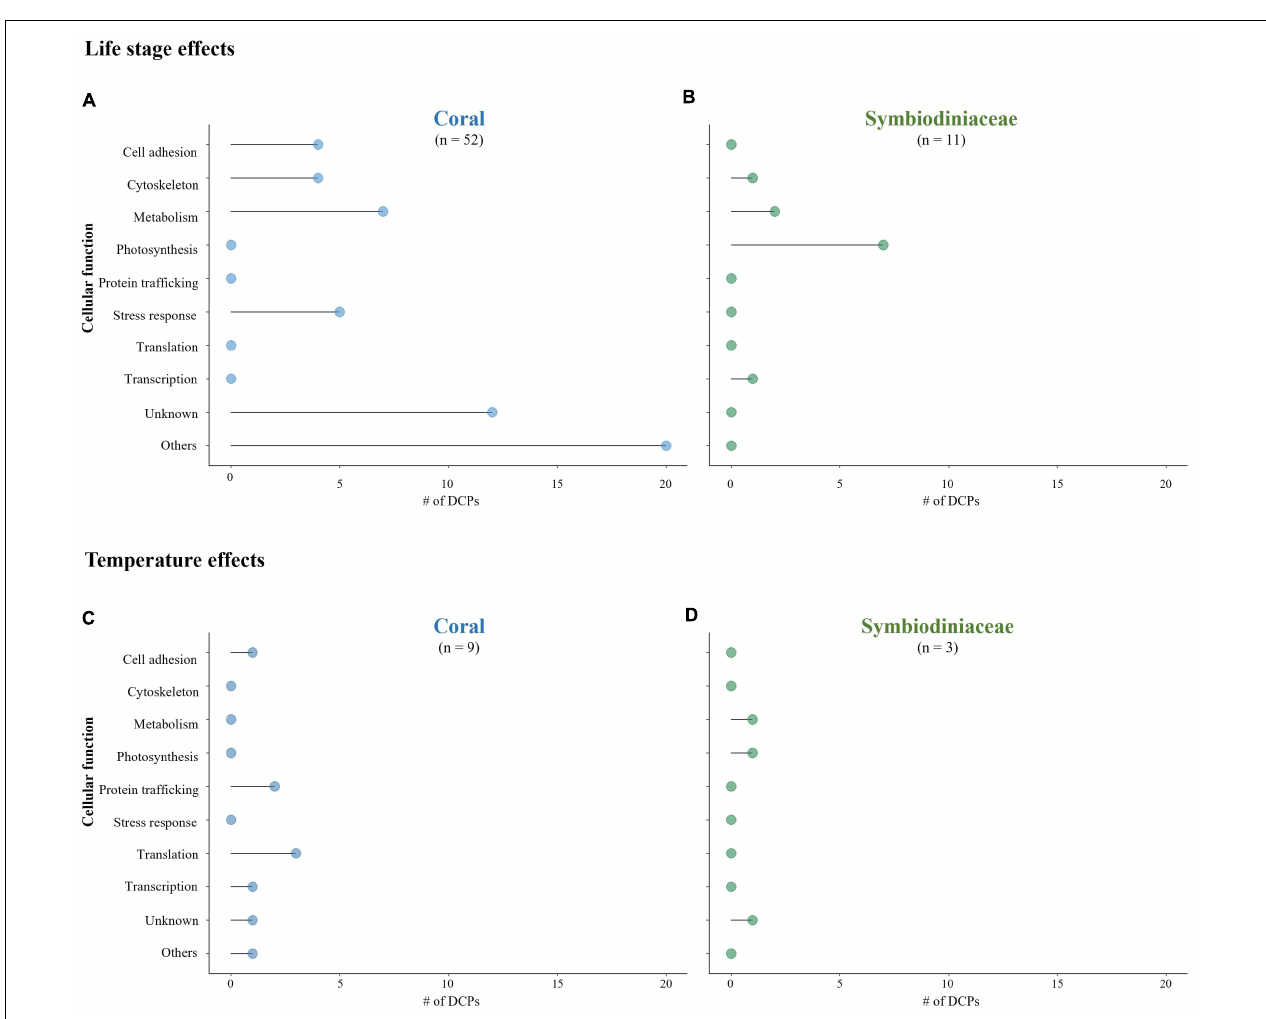
FIGURE 2 | Comparison of differentially concentrated proteins (DCPs) and their associated cellular function in the Pocillopora acuta coral host (A,C) and Symbiodiniaceae endosymbionts (B,D) ; DCPs associated with life stage (A,B) and temperature (C,D) .